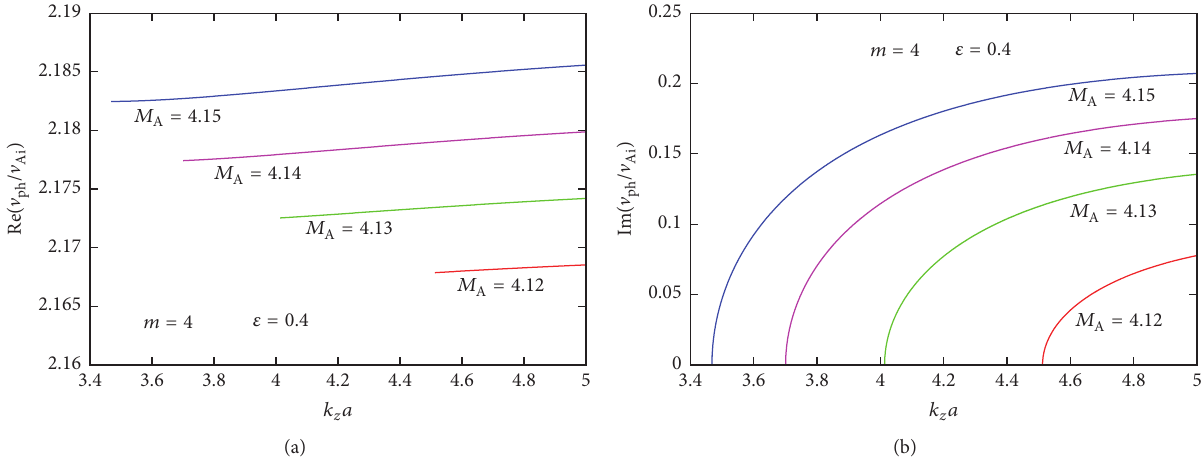
Figure 12: (a) Dispersion curves of unstable ( 𝑚 = 4 ) MHD mode propagating in a moving twisted flux tube of incompressible plasma (modeling jet #11) at the same parameters as in Figure 8 and for 𝑀 A = 4.12 , 4.13, 4.14, and 4.15. (b) The normalized growth rates for the same values of 𝑀 A